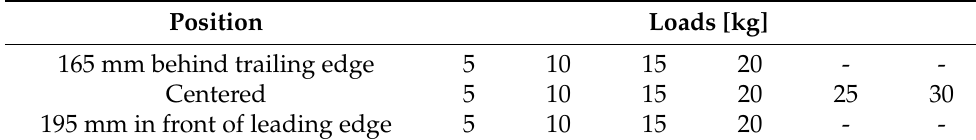
Table 4. Test matrix for static test load test.